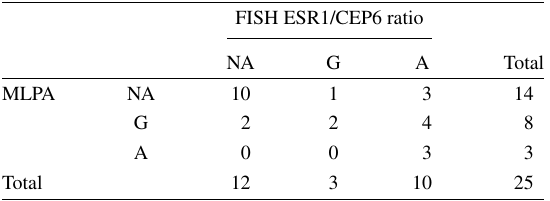
Concordance between ESR1 MLPA ratio and FISH ESR1/CEP6 ratio